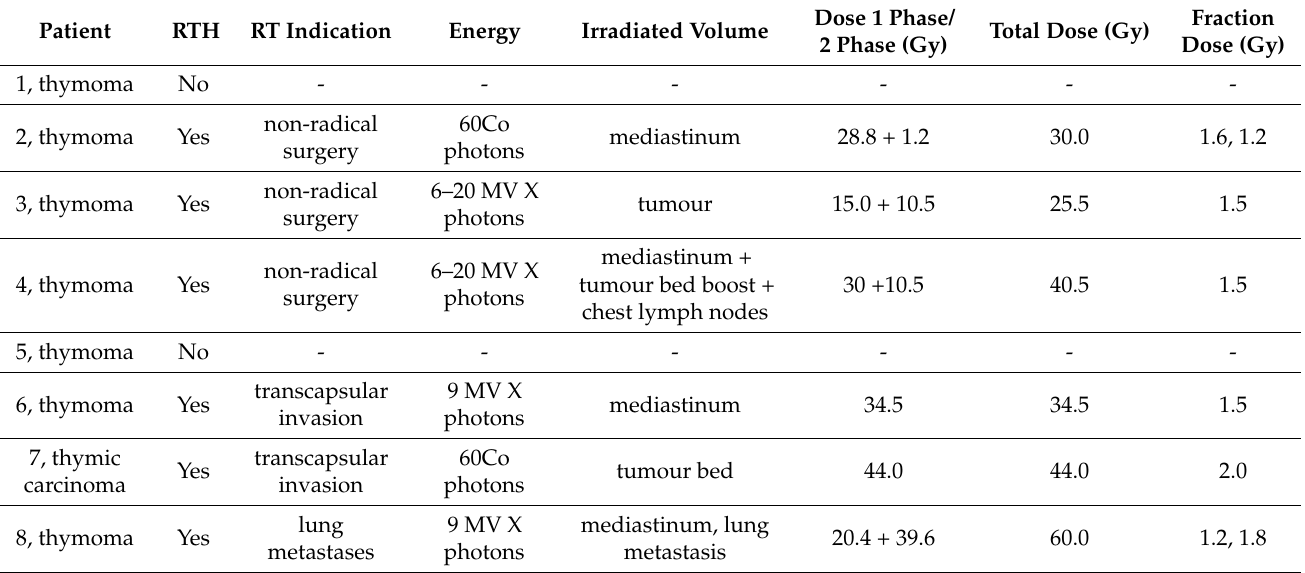
Table 4. Radiotherapy